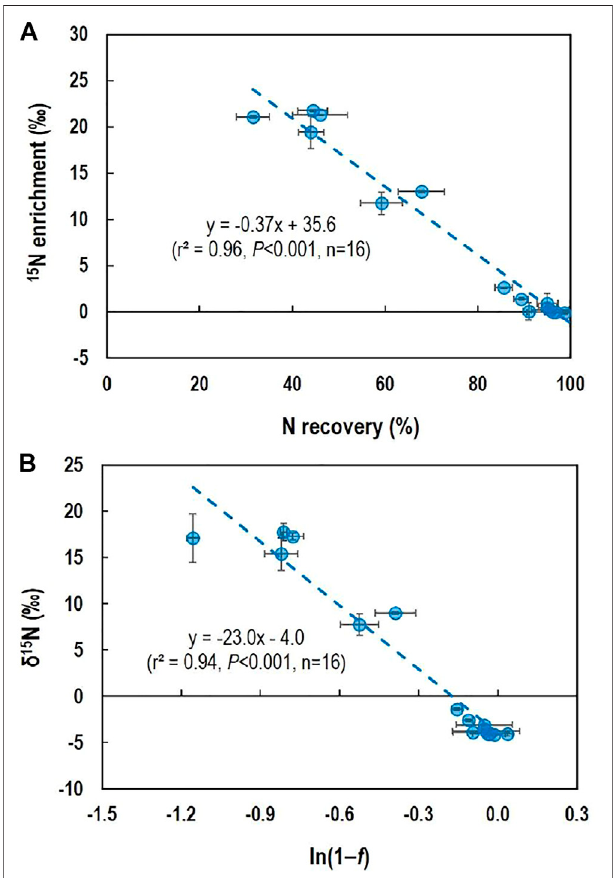
FIGURE 2 | Relationship between δ 15 N-NH 4+ and N loss during evaporation of (NH 4 ) 2 SO 4 solution to dryness under different pH and using different evaporation methods: (A) relationship between 15 N enrichment (difference in δ 15 N-NH 4+ between direct measurement and measurement with dried salts) and N recovery after evaporation and (B) relationship between the δ 15 N-NH 4+ measured with dried salts and the fraction (1 − f) of NH 4+ recovered after evaporation for Rayleigh isotope enrichment model. Horizontal and vertical bars are standard deviation of the means ( n = 4).